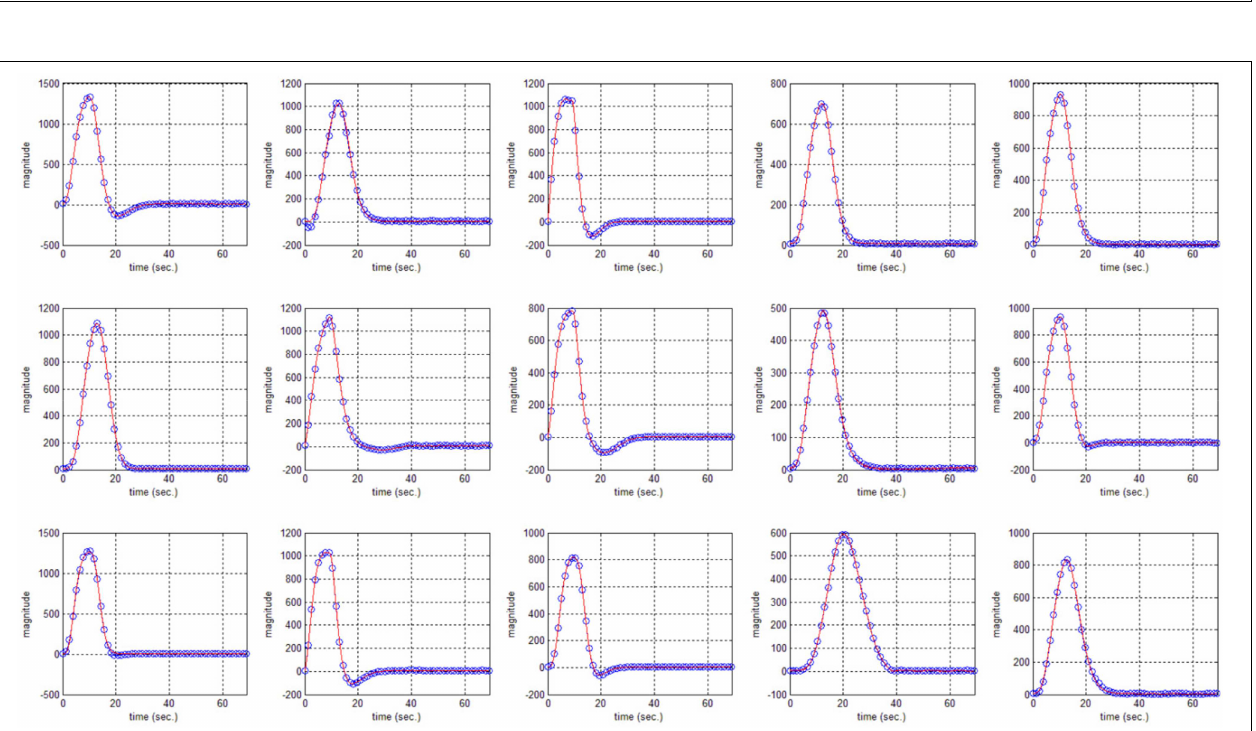
FIGURE 4 | HRF using actual values of free parameter (solid) and HRF using estimated values of free parameter (circular blue).